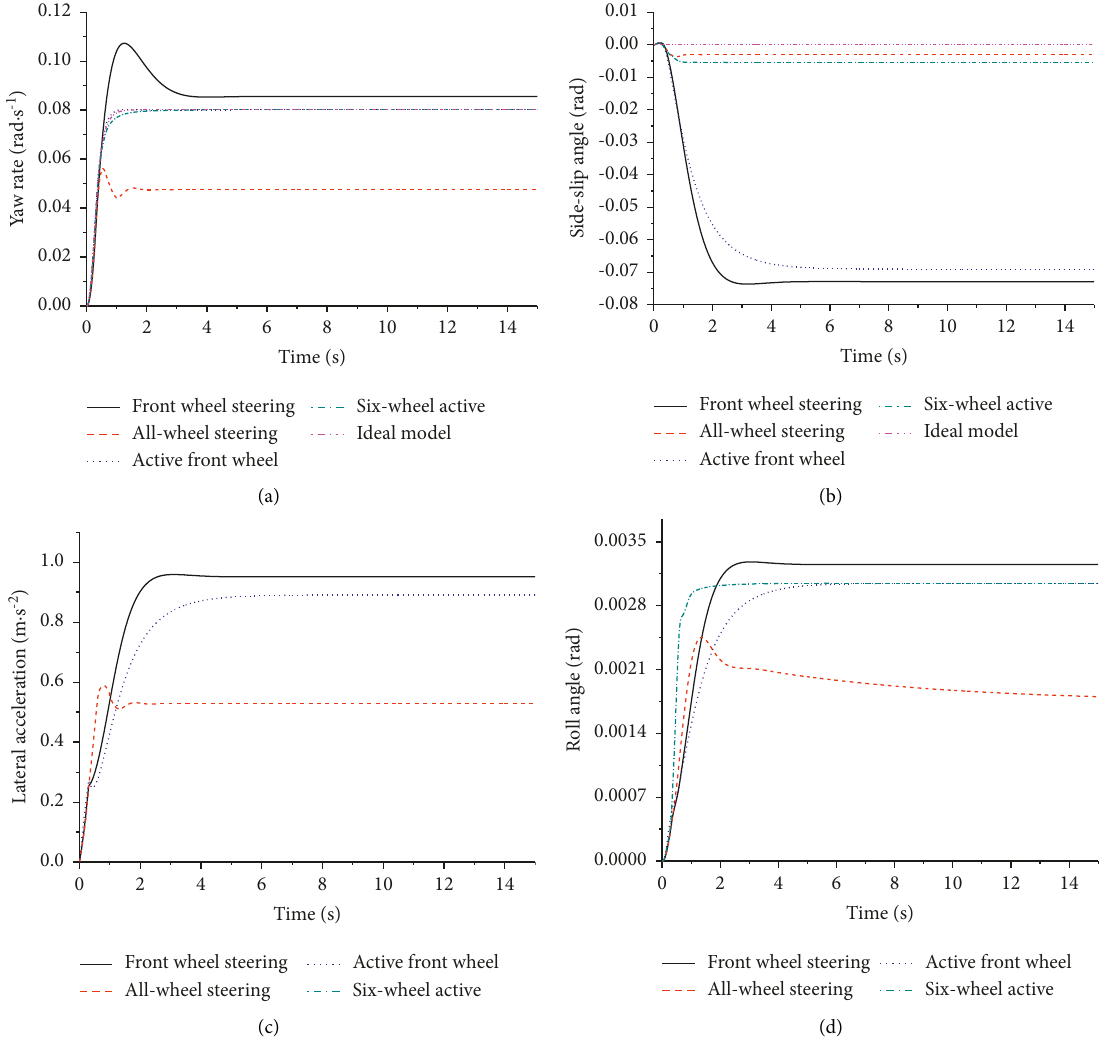
Figure 9: Comparison of different control strategies (40 km/h). (a) The yaw rate. (b) The side-slip angle. (c) The lateral acceleration. (d) The roll